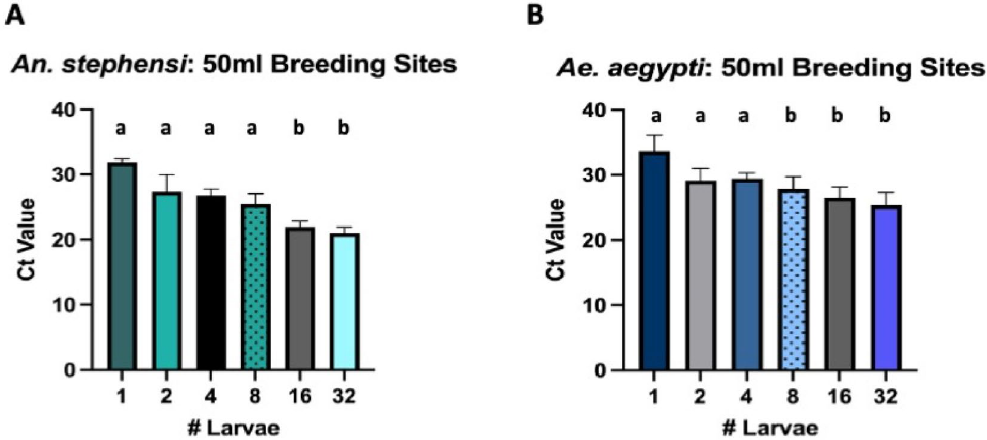
Figure 2. Taqman qPCR detection of An. stephensi ( A ) and Ae. aegypti ( B ) from 50 ml breeding sites. qPCR detection for all extractions were run in technical triplicate. Conditions sharing a superscript do not differ significantly (Dunn’s multiple comparisons test, p > 0.05). Error bars indicate 95% confidence intervals (CIs).